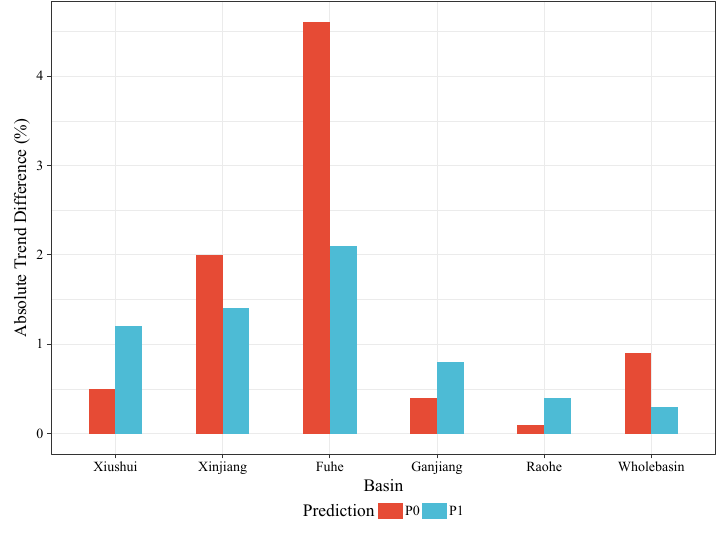
Figure 7. Absolute differences between predicted and observed runoff trend. P0 and P1 stand for prediction without consideration of n and prediction with consideration of n ,